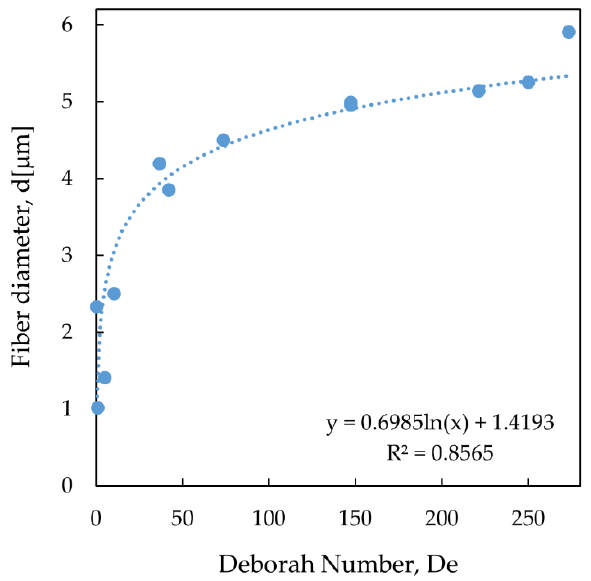
Figure 6. Diameter of the fibers as function of the Deborah number.